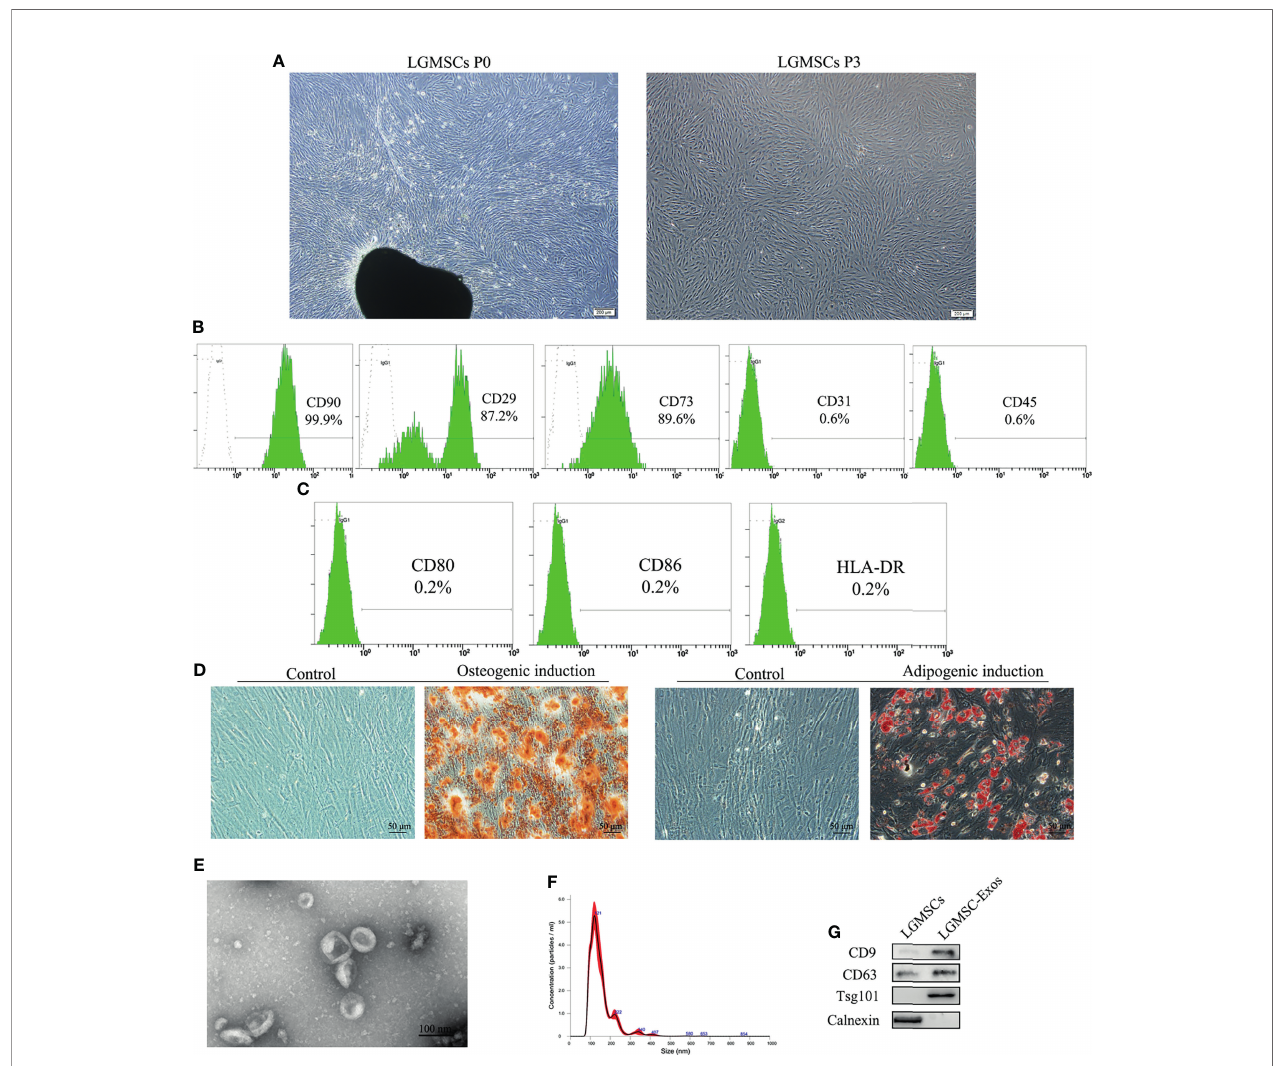
FIGURE 1 | Isolation and identi fi cation of LGMSCs and LGMSC-derived exosomes. (A) LGMSCs at passage 0 (P0) and P3; (B) Flow cytometry results of surface markers of LGMSCs; (C) Flow cytometry results of costimulatory molecule expression on LGMSCs; (D) osteogenic and adipogenic induced LGMSCs stained using Alizarin red staining and oil red O; (E) Representative TEM (bar = 100 nm) micrographs of LGMSC-Exos; (F) particle size of LGMSC-Exos analyzed using NTA; (G) Western blotting analysis of CD9, CD63, Tsg101, and calnexin in LGMSCs and